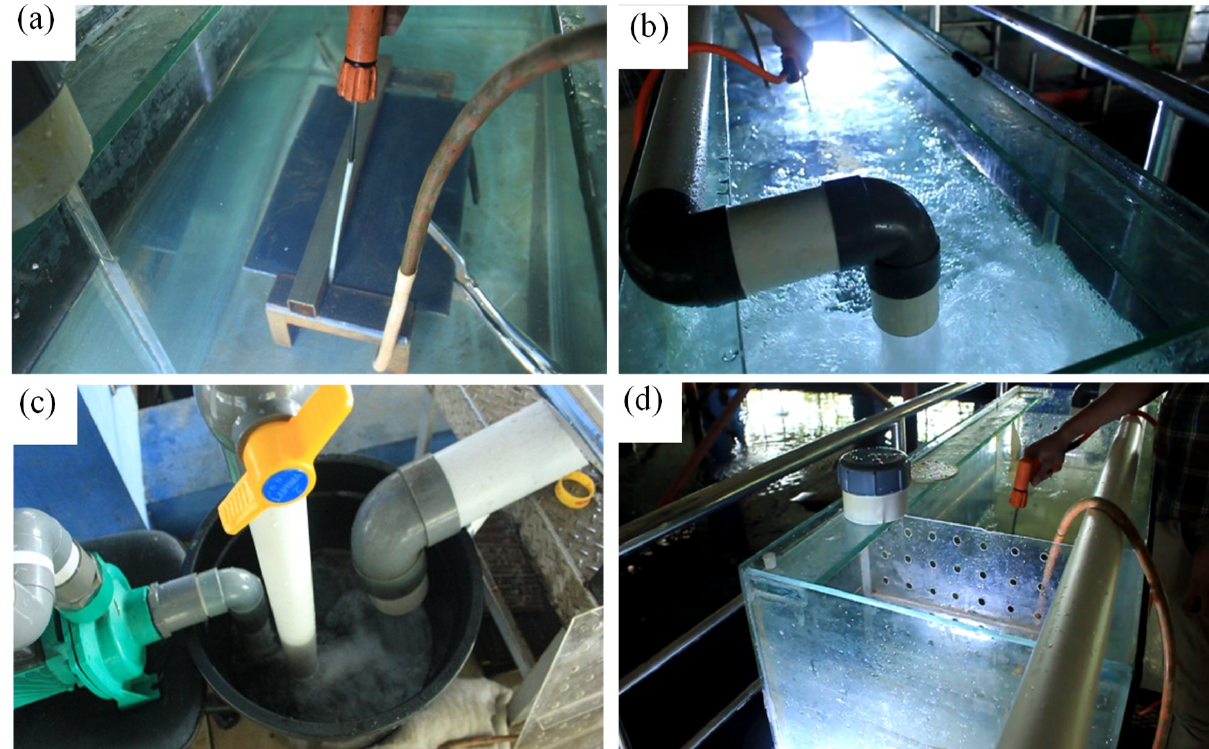
Figure 2. The s control system using: ( a ) jig specimen welding, ( b ) pipe water flow system, ( c ) reservoir system, and ( d ) baffle bulkhead installation.